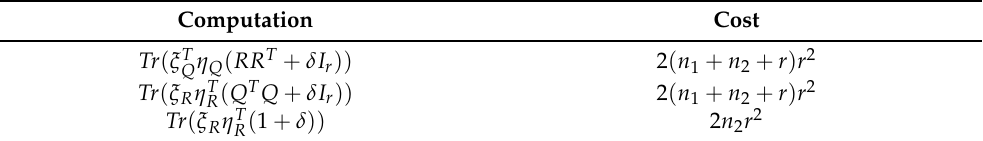
Table 2. Computation costs of the